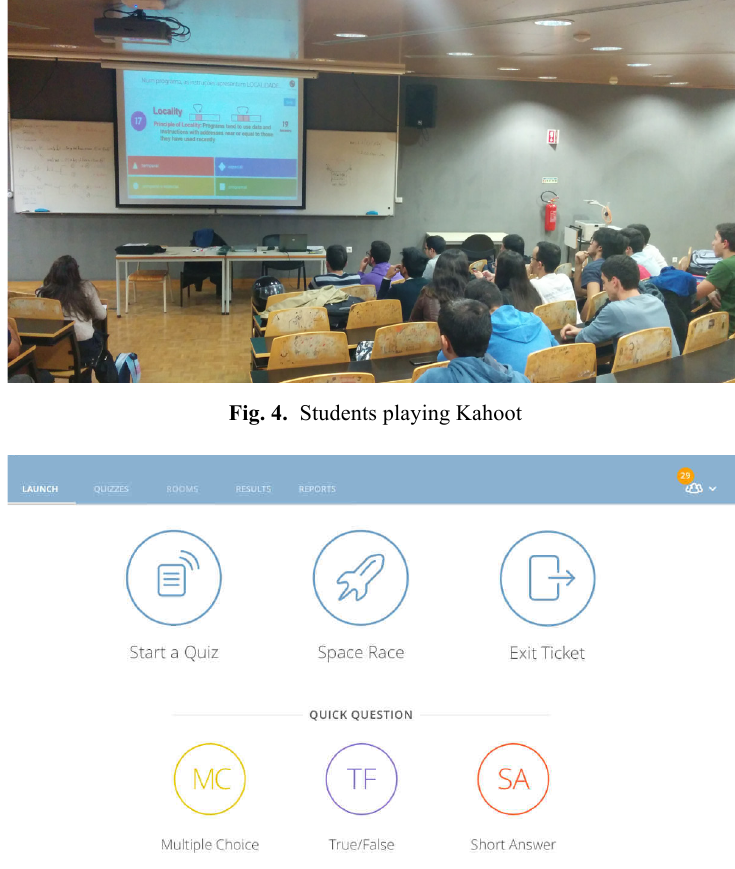
Fig. 3. Game beginning